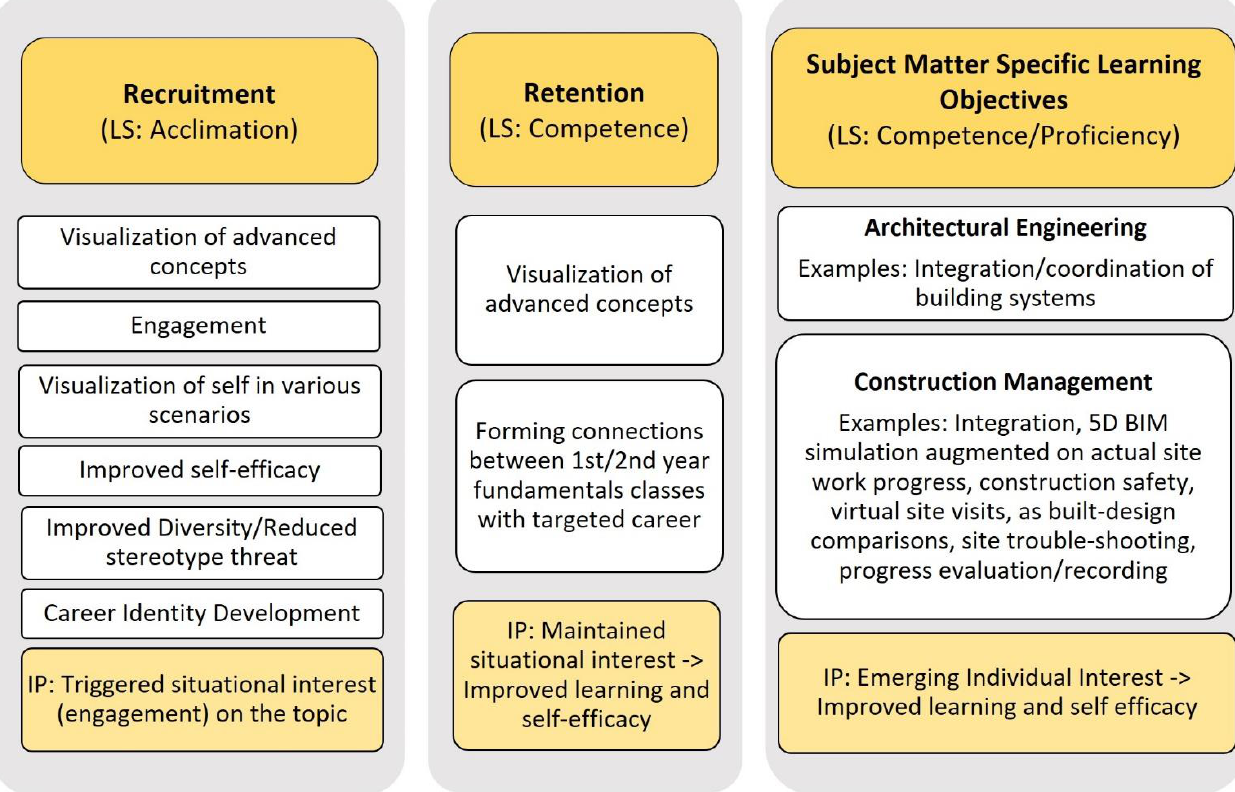
Figure 3. General categories for the educational objectives within Architectural Engineering and Construction education. (LS: Learning stage, IP: Interest Phase per MDL framework).